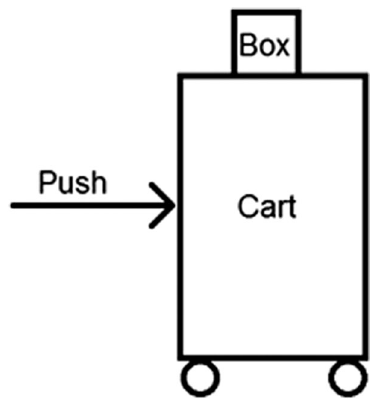
FIG. 8. Figure for friction post-test problems 4 – 5.